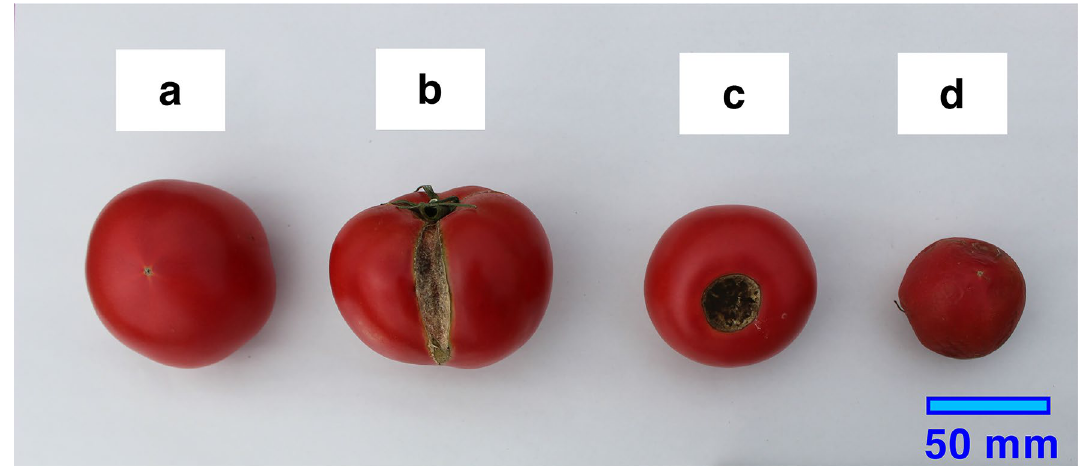
Figure 2. The separate types of tomato fruits harvested. ( a ) A fresh-marketable fruit, ( b ) a dehiscent (cracking) fruit, ( c ) a fruit infected by blossom-end rot and ( d ) a fruit that was too small (less than 115 g in fresh mass). ( b–d ) Typical types of unmarketable tomato fruits in Japan. The photos were taken by S. Horimoto (the first